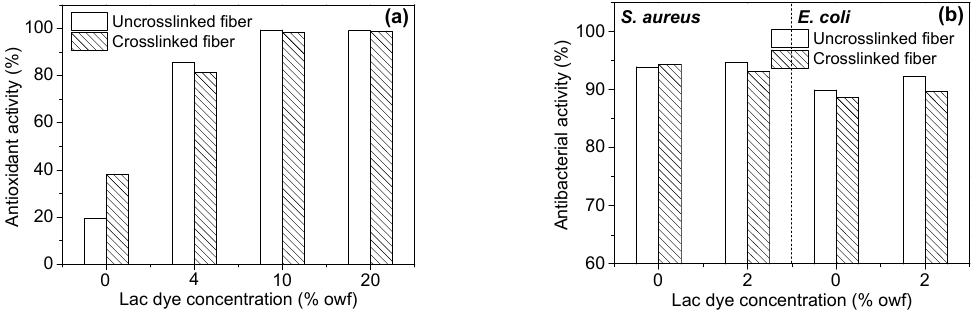
Figure 7. Antioxidant ( a ) and antibacterial ( b ) activities of the crosslinked and dyed chitosan fibers.